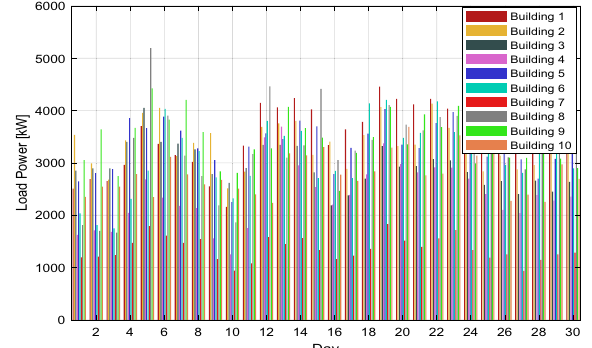
Figure 4. The electricity load profile of 10 buildings over the month.